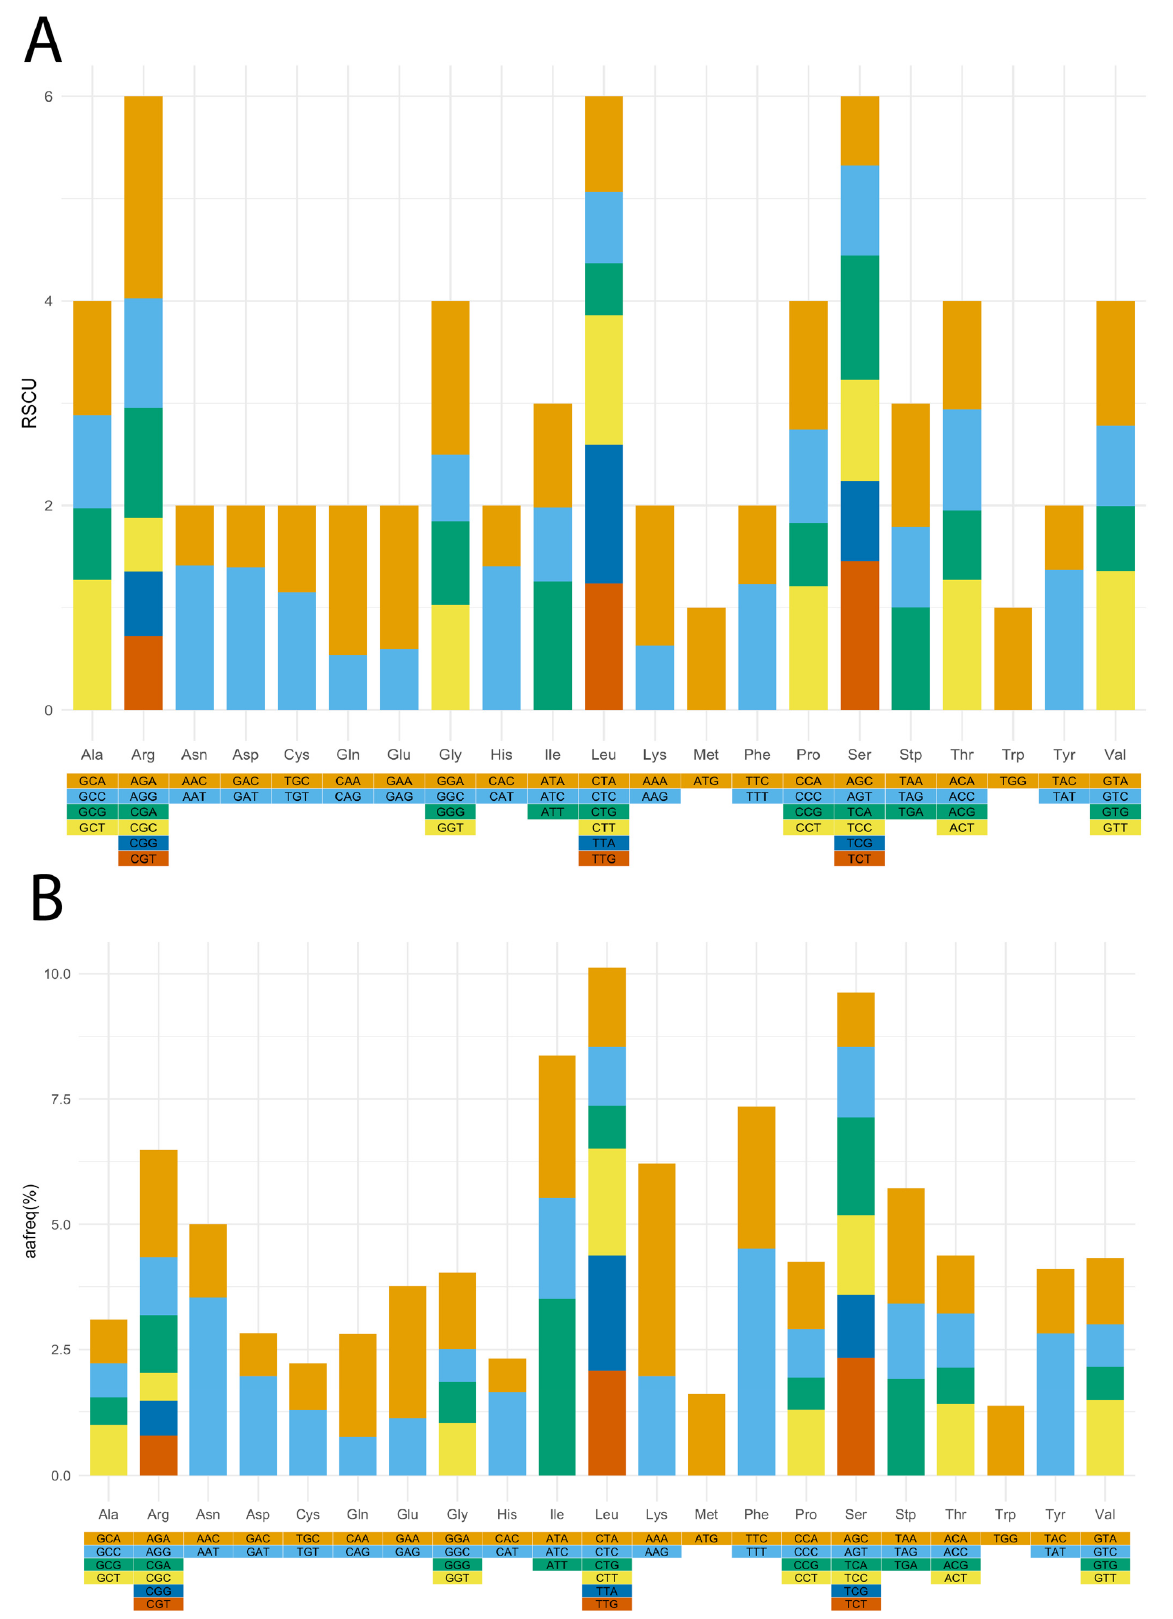
Figure 2. Codon usage analysis and amino acid frequencies (%) in V. floribundum cp genome. ( A ) Relative synonymous codon usage (RSCU). ( B ) Amino acid frequencies (aafreq %). The x-axis shows codons that are represented by different